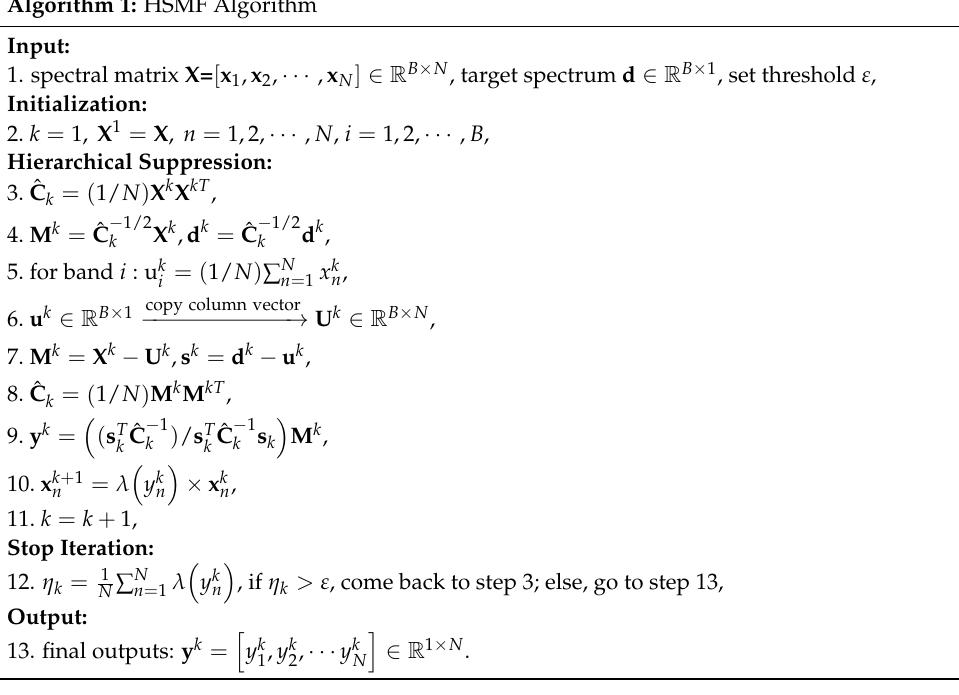
Algorithm 1: HSMF